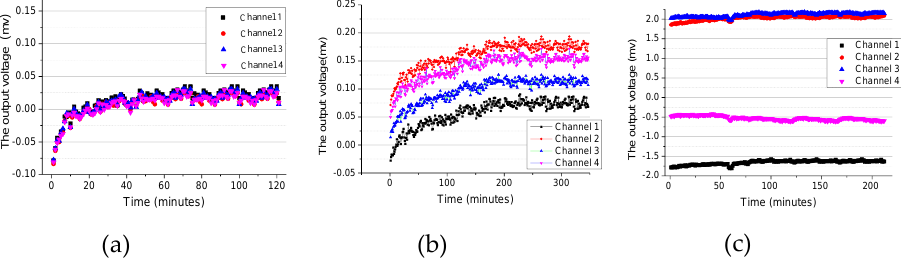
Figure 7. ( a ) The output voltage of A / D converter without input. ( b ) The output voltage of conditioning circuit without PSD input. ( c ) The output voltage of conditioning circuit with PSD input. Table 1. The output voltage statistics of each channel with different conditions.